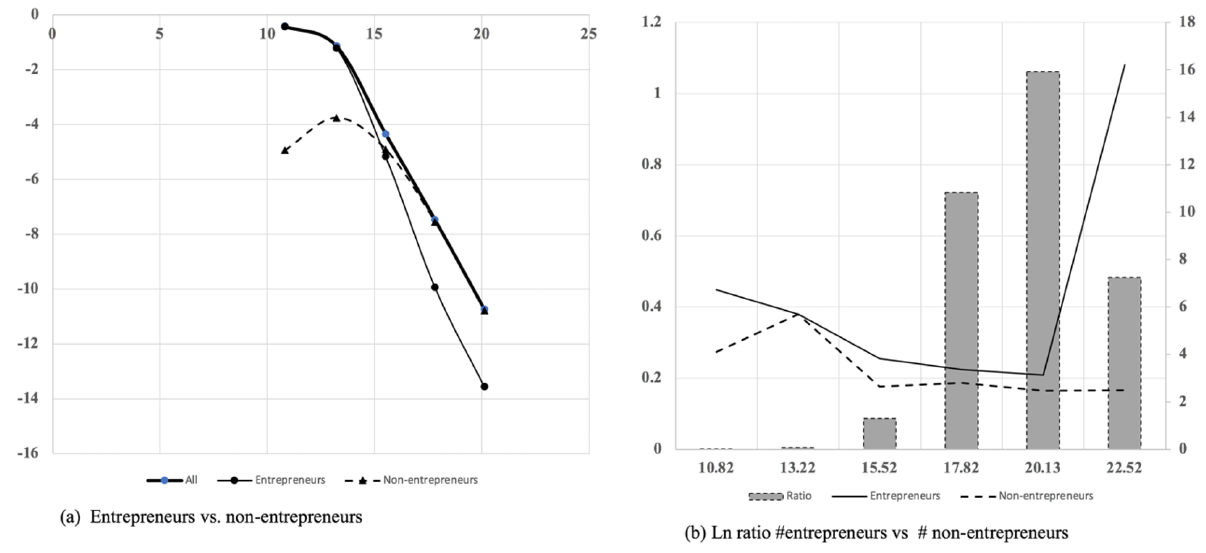
Figure 6. Assets with a value greater than